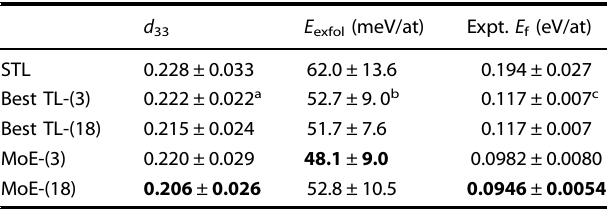
Table 2. Comparing MoE with the best-performing pairwise TL model.